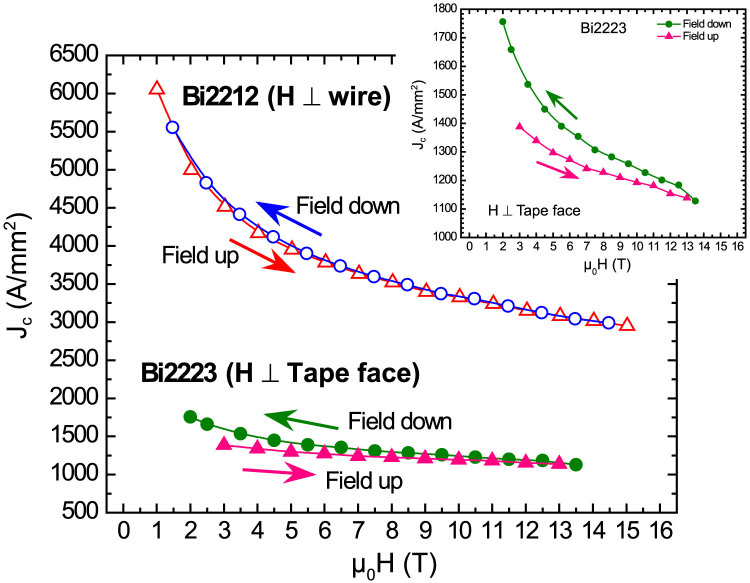
Comparison of the superconducting critical current density Jc(H, 4.2 K) of the Bi2223 flat tape and the Bi2212 round wire.The field H was applied normal to the wire axis for Bi2212, and to the tape face for Bi2223, respectively. The triangles of Bi2212 and Bi2223 indicate Jc measured in increasing field, whereas the circles of Bi2212 and Bi2223 represent Jc in decreasing field. Note that Jc of Bi2212 round wire is approximately 3 times larger than that of the Bi2223 flat tape and is without any field hysteresis, which is quite evident in Bi2223 and is shown more clearly in the inset.